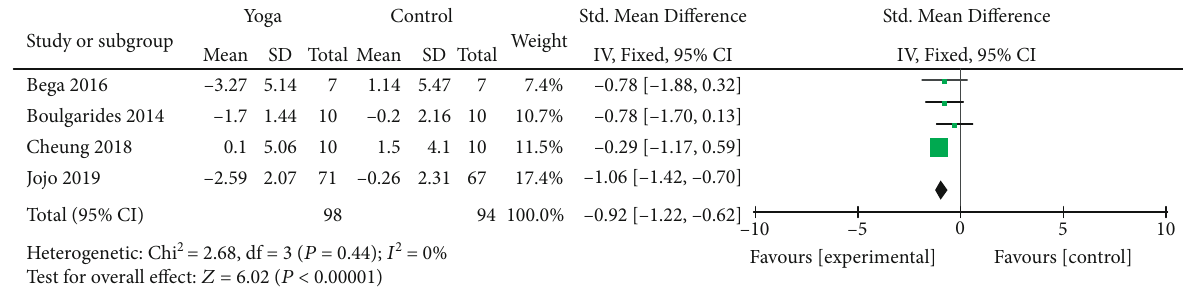
Figure 8: Forest plot from the meta-analysis of yoga on